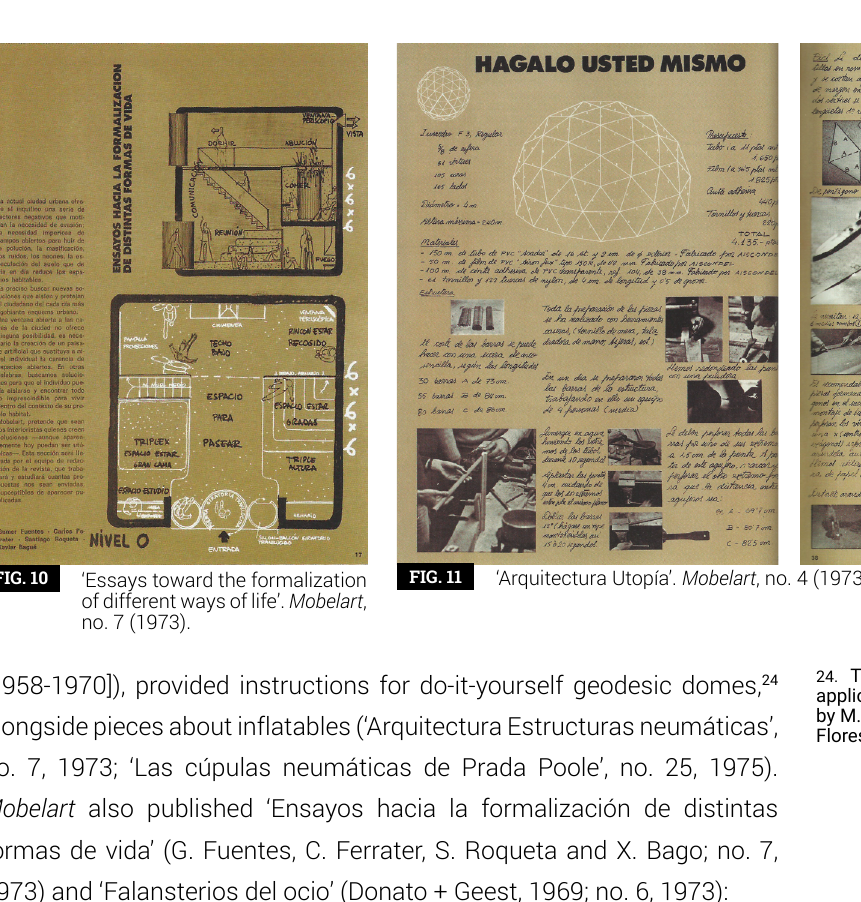
25. Donato + Geest, 1969, “Convento o cámping... Campamento o